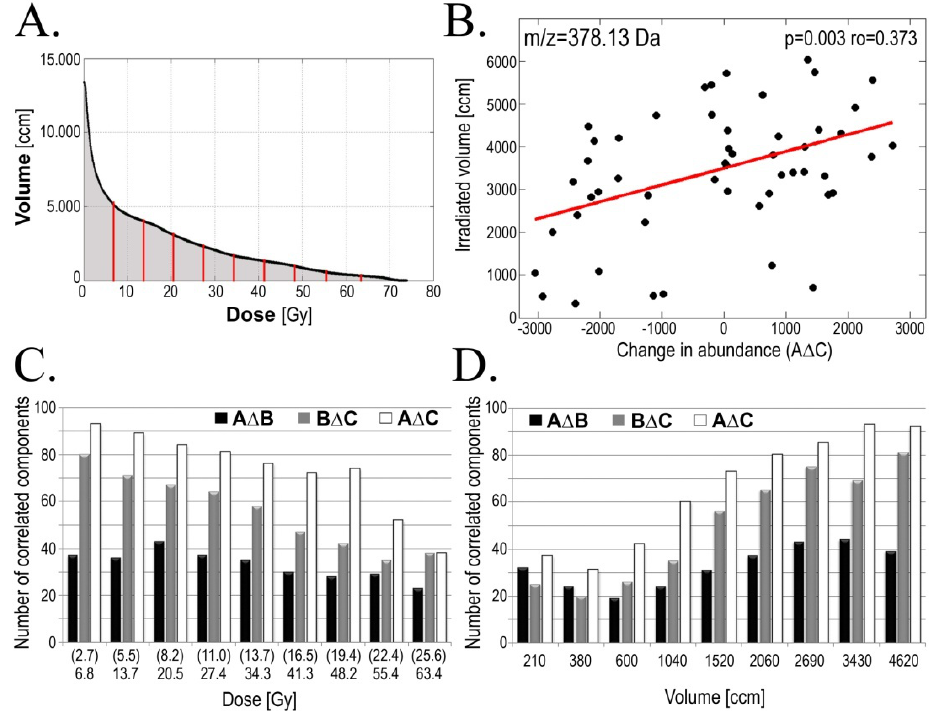
Figure 4. Dose-volume effects in serum lipidome changes. (Panel A ): Averaged Dose-Volume Histogram; doses corresponding to deciles of the area under curve of the histogram are marked with red lines; (Panel B ): Correlations between volume of tissue irradiated with 13.7 Gy and changes in abundance of the m / z = 378.13 Da component in pre- and post-treatment samples (C-A; arbitrary units); Numbers of serum lipidome features correlating with tissue volumes irradiated at a given dose of radiation (Panel C ) or doses of radiation delivered to a given tissue volume (Panel D ). Shown here are the A ∆ B (black bars), B ∆ C (grey bars) and A ∆ C (empty bars) changes; p = 0.05 was selected as a statistical significance threshold (doses in parentheses refer to A ∆ B